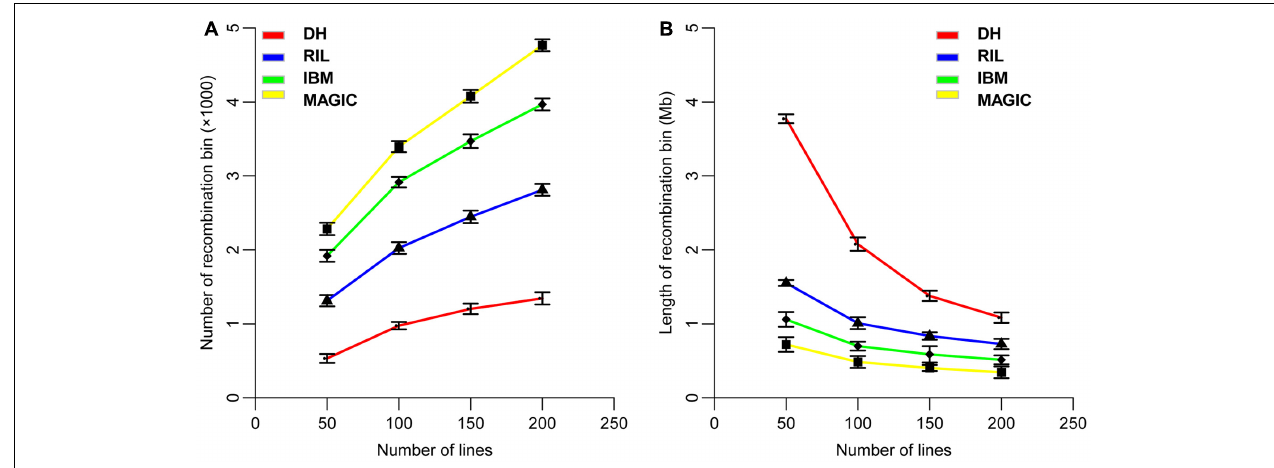
FIGURE 2 | Distribution of the number and size of recombination bins in four types of populations. (A) Variation of recombination bin number with different sub-sets of line numbers in four populations. (B) Variation of recombination bin size with different sub-sets of lines in four populations. DH, double haploid; RIL, recombination inbred lines; IBM, intermated B73xMo17; MAGIC, multi-parent advanced generation inter cross.